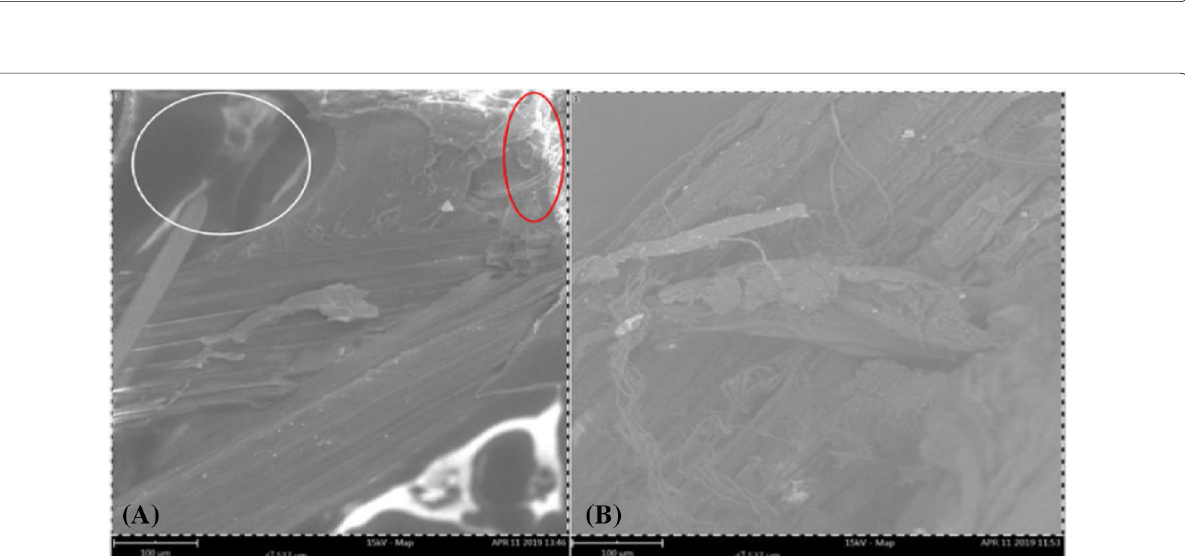
Fig. 3 FTIR spectra of treated and untreated composites (Alavudeen et al. 2015)